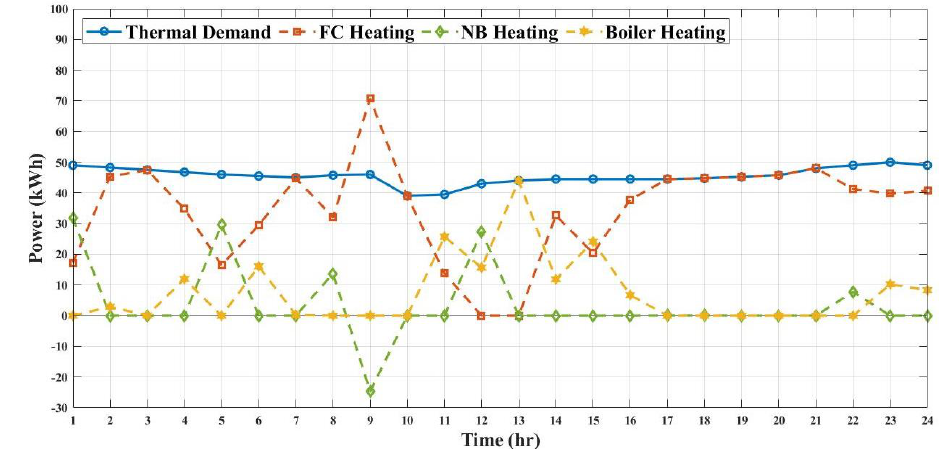
Figure 17. Thermal powers for Case 6.